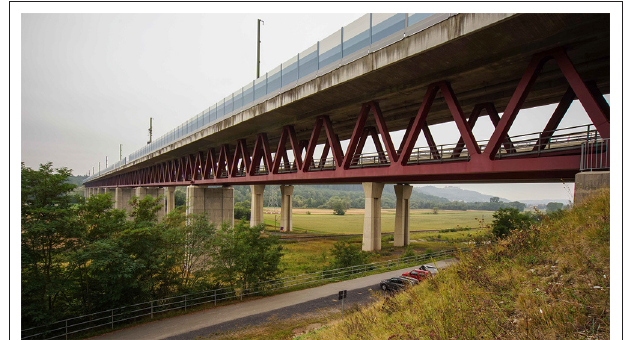
FIGURE 1 | Itz valley railway viaduct. The motorway viaduct of the A 73 runs parallel to the railway viaduct (in the background). Reproduced from Wenner et al. (2019) with permission from [Ludolf Krontal].